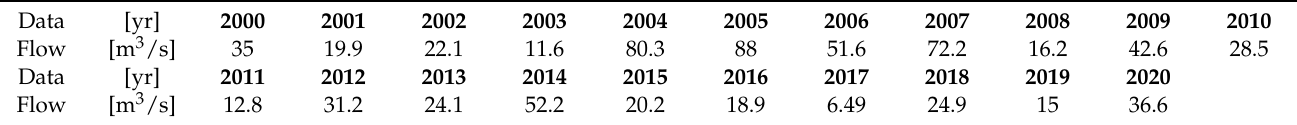
Table 4. Observed data from the Prigor station.